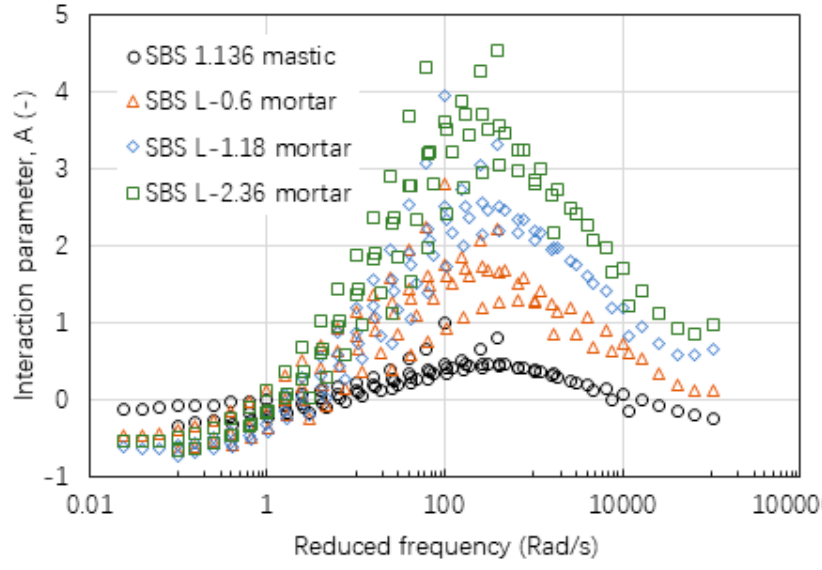
Figure 10. Interaction parameter of A values of mastic and mortars based on AC ‐ 20 mixture.